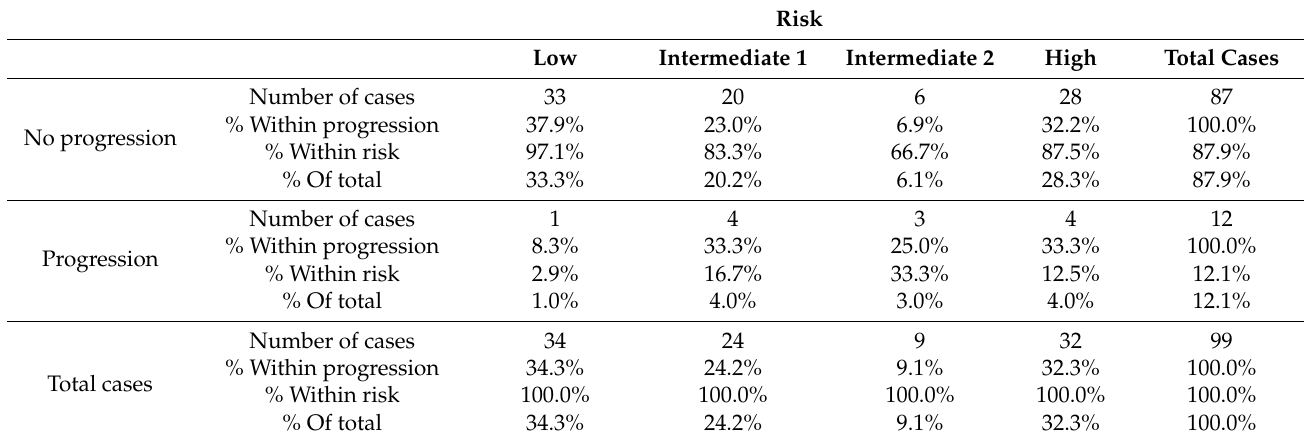
Table 3. Cross-tabulation of the reclassified risk groups versus